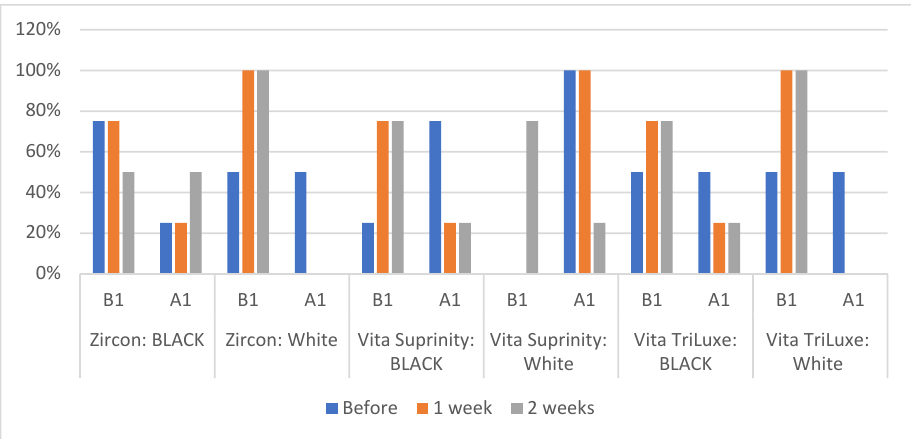
Figure 5. Comparison of color changes between basic colors of VITABAN Classical shade guide and the tested specimens after staining with ST at different time intervals. The 3D images of Ra graphical output representing the roughness differences between black and white ST groups in relation to the tested CAD/CAM restorative materials are presented in Figure 6. Zirconia samples recorded the highest Ra value with 0.28 and 0.36 µm in black and white ST, respectively. While Ra for Vita TriLuxe samples was the lowest with 0.18 and 0.09 µm for black and white ST, the recorded Ra values for Vita Suprinity were 0.30 and 0.09 µm for the tested ST.